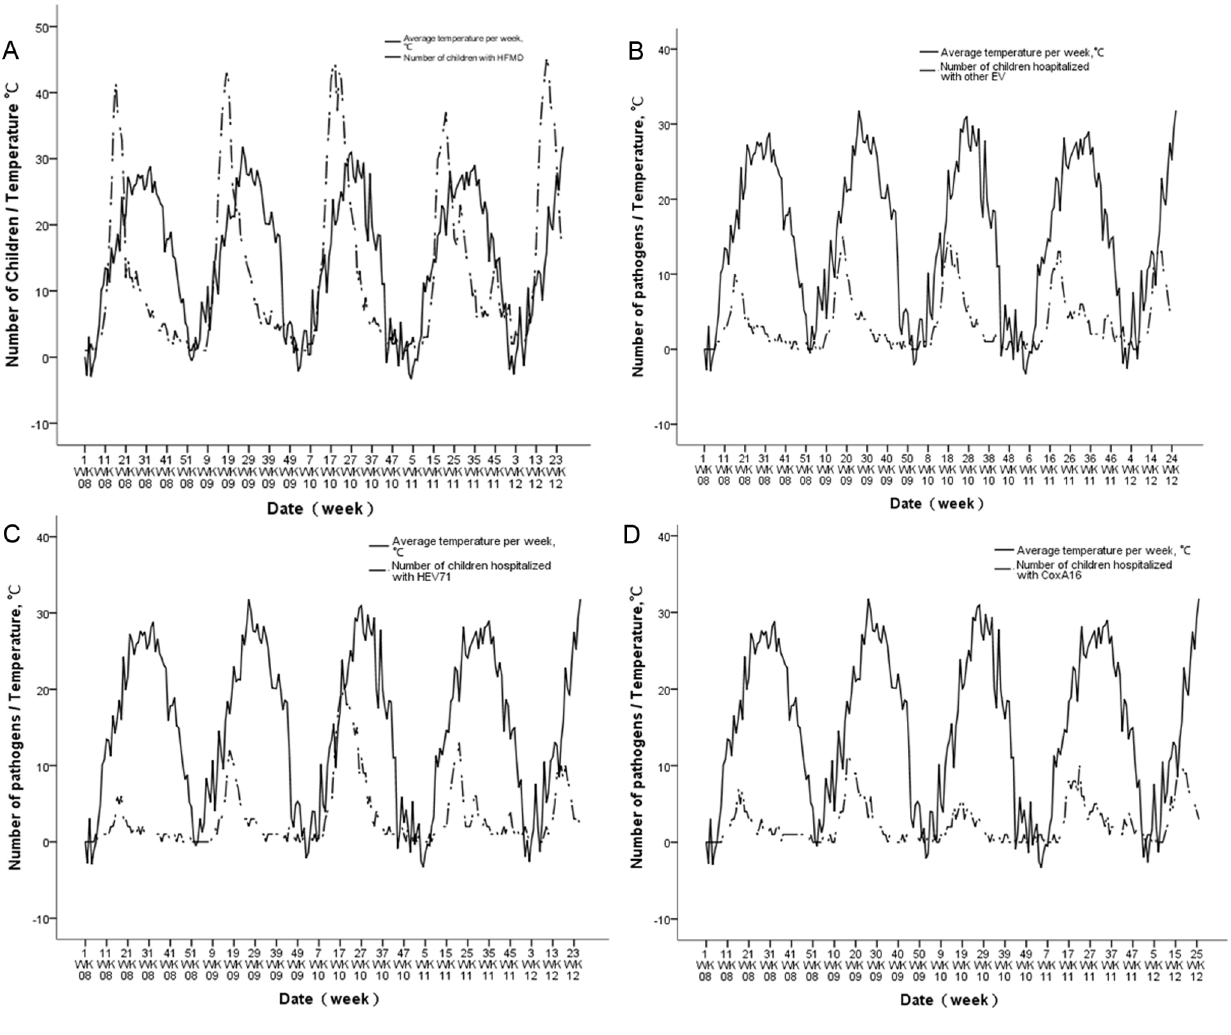
Figure 2. Weekly numbers of hospitalized children with HFMD in Zhengzhou, China from January 2008 to June 2012 compared to crude meteorological variables for the same period. An alternate course is seen between temperature and the pathogens. HFMD (A), other EV(B), HEV71(C) and CoxA16(D). doi:10.1371/journal.pone.0087916.g002 PLOS ONE |